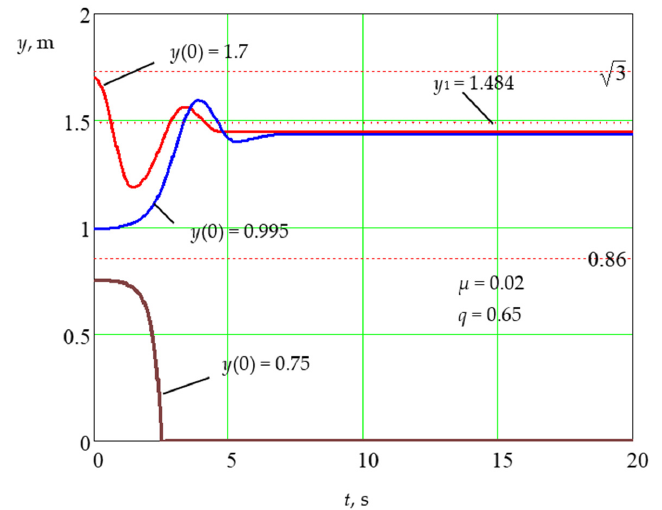
Figure 13. Movement of a system with an increased coefficient of friction from different initial points with a thread stiffness sufficient to cause free vibrations.